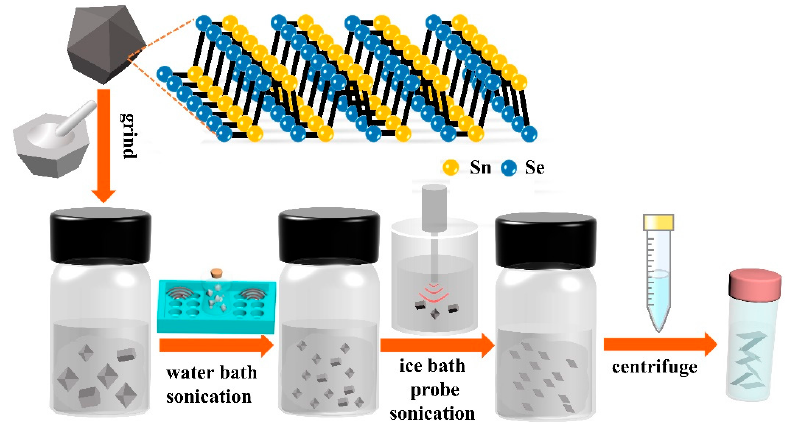
Figure 1. Schematic illustration of LPE to form SnSe NSs.